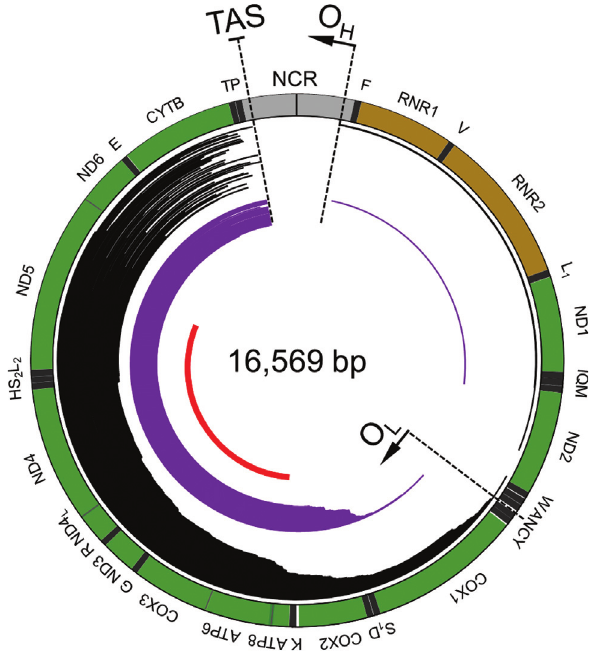
Figure 2 - Diagram of the distribution of selected deletions within the hu- man mitochondrial genome. The location of the deletions corresponds to the distribution of lines inside the mtDNA ideogram. Each line represents a single deletion. The location of 152 reported single mtDNA deletions is presented as black lines. The location of 86 reported multiple mtDNA de- letions associated with progressive external ophthalmoplegia (PEO), in- cluding those generated upon mutations in POLG1 and TWNK , is pre- sented as light blue lines. The location of the common deletion is presented as the red line. Origins of replication O H and O L , as well as the termination associated sequence (TAS) are labeled. Protein-coding genes are colored in green; ribosomal RNAs are colored in brown; transfer RNAs are colored in grey; the non-coding region (NCR) is colored in light grey. The diagram was generated with and modified from the mitochon- drial DNA breakpoints database, MitoBreak (Damas et al. ,